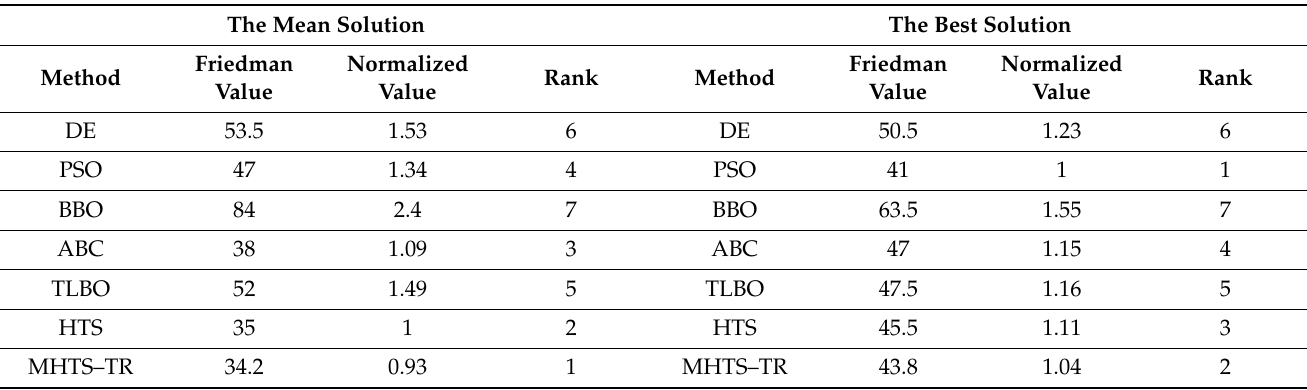
Table 3. Friedman rank of C01–C13 for the solutions obtained by the MHTS–TR and other MHAs. (The experimental results of the competitors are derived from the literature [18]).